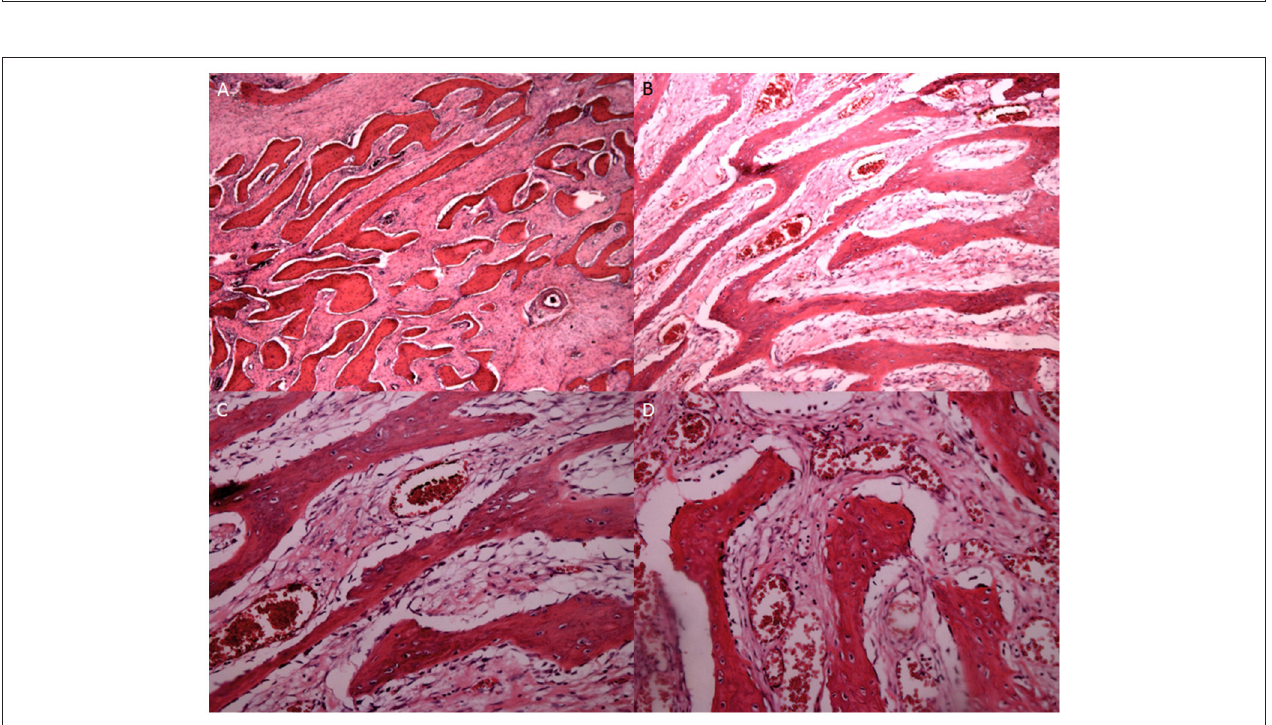
FIGURE 6 | Histopathological examination of intraosseous vascular granulation tissue at different stages of OS (H&E stain × 200). (A) Internal hemorrhage were observed within the bone tissues at G1 stage. (B) Granulation tissue and responsive hyperosteogeny increased at G2 stage. (C) Granulation tissue and responsive hyperosteogeny increased further at G3 stage. (D) Giant granulation tissue and responsive hyperosteogeny at G4 stage.